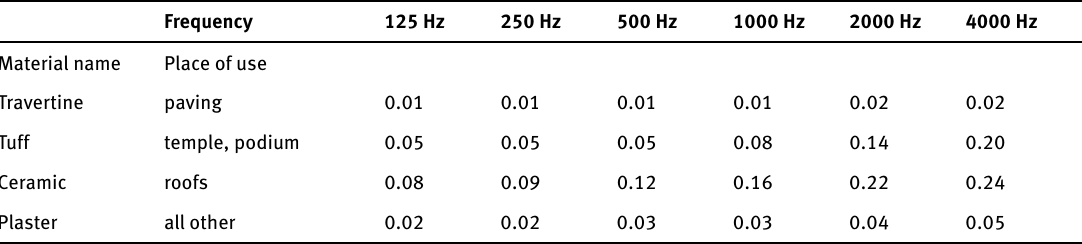
Table 1. Sound absorption coefficients of materials used in